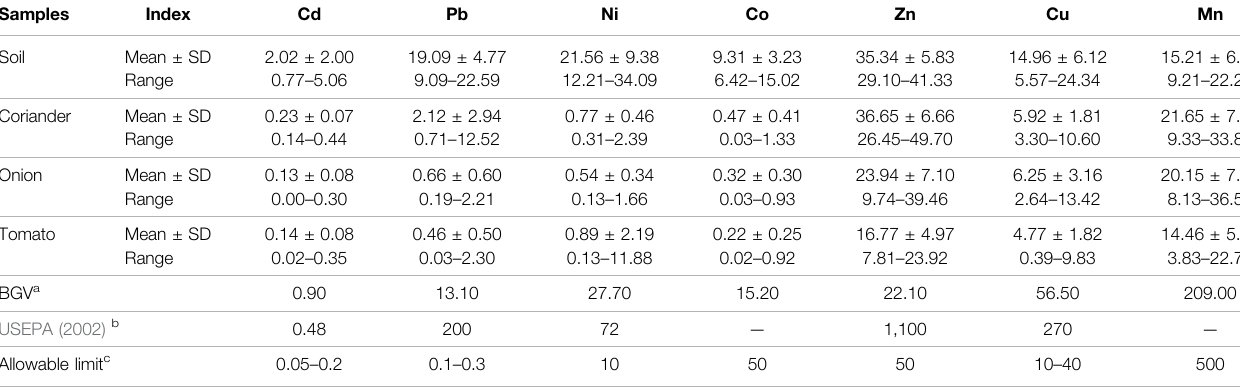
TABLE 2 | Average concentration (mg/kg) of heavy metals in soil and vegetable samples of the study area (N = 28) on dry weight (dw) basis. Samples